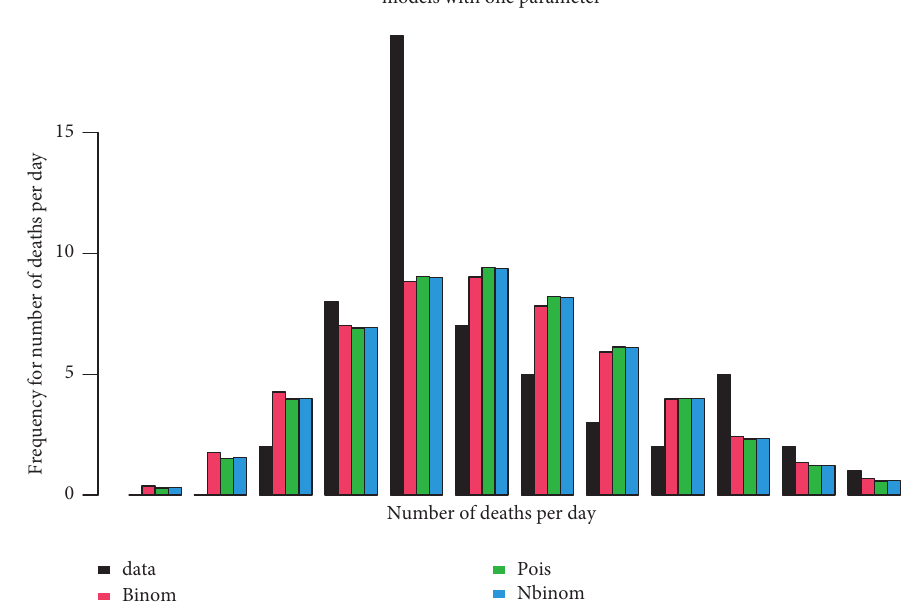
Figure 3: Graphical plots for the expected frequencies and the data using the PMF of different one parameter distributions, where the x -axis represents the number of deaths per day and the y -axis represents the frequency for this number.